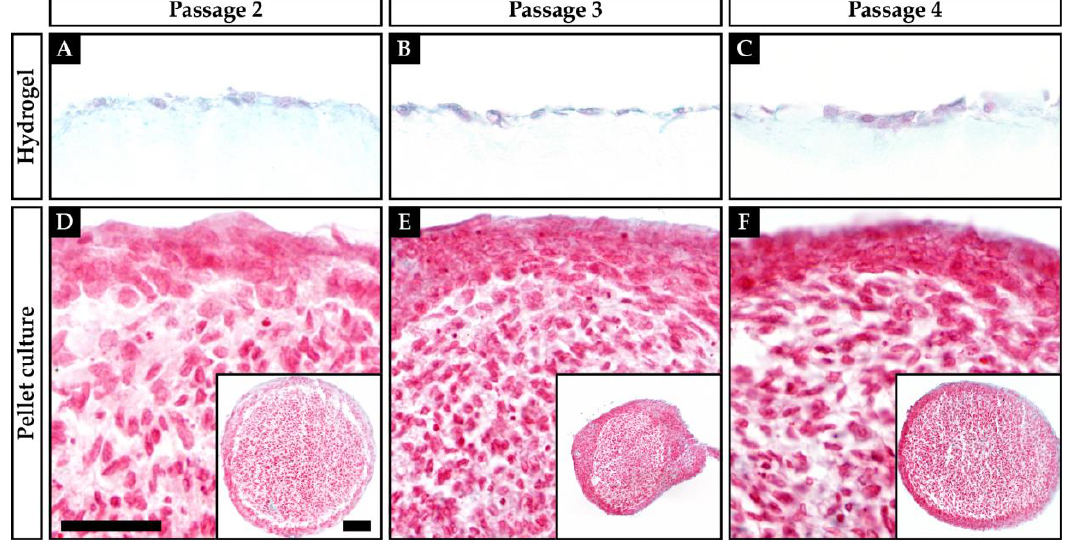
Figure 1. Safranin O/Fast Green staining of non-osteoarthritic (non-OA) human articular chondrocytes growing on a hydrogel ( A – C ) or in pellet culture ( D – F ). ( A + D ) Passage 2; ( B + E ) Passage 3; ( C + F ) Passage 4. Scale bars: 50 µm ( A – F ), 100 µm ( D – F , inserts).